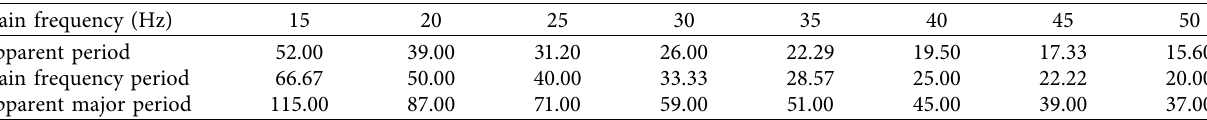
Table 4: Values corresponding to the apparent period, main frequency period, apparent major period at different main frequencies. Main frequency